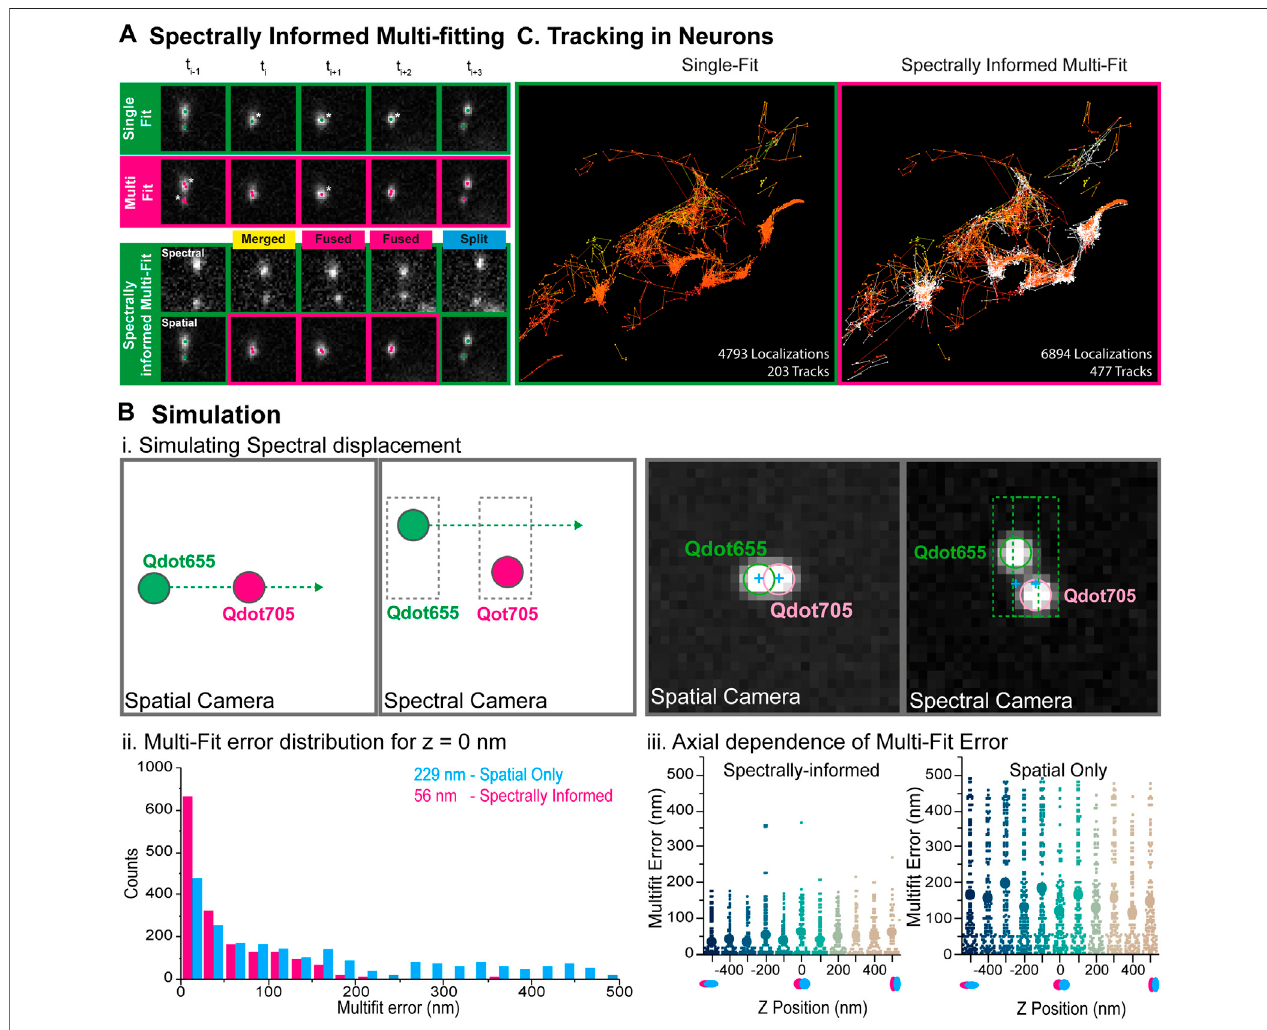
FIGURE4| Spectrally-informedmulti- fi ttingprincipleandbenchmarkingthroughsimulations. (A) Principleofthespectrally-informedmulti-Gaussian fi ttingmethod. When two fl uorescent single particles diffuse together within an area smaller than the diffraction limit of light, it becomes impossible to localize them individually and extract their exact trajectories. A systematic single Gaussian- fi tting approach leads to under-counting localization (top) whereas a systematic multi-Gaussian fi tting approach sometime leads to over-counting localizations (middle) (Stars indicate over- or under-counting errors in the localization process). If those particles have different spectral signatures, they will be separated in the spectral channel, allowing to precisely determine the number of particles, and to use the multi-Gaussian fi tting algorithm when needed to retrieve their coordinates (bottom). The Spectrally-informed multi-Gaussian fi tting (magenta) occurs when two emitters overlap on the spatial channel (single localization) and two distinct localizations are detected on the spectral channel. (B) Multi-Gaussian fi tting simulation for benchmarking. (i.) Simulation principle: Two spectrally-distinct emitters (QDot 655 and QDot 705) were simulated for the spectral and spatial cameras for 320 frames. QD655 displaces horizontally across the fi eld of view at 10nm/frame such that the emitters begin separated, then overlapped on the spatial camera but not on the spectral camera, and fi nally separated again. Right: True camera noise and PSF sizes were used in the simulations. The two emitters overlap on the spatial camera, but not on the spectral camera. (ii.) Thelocalizationerrorforeachofthemulti-Gaussian fi ttingmethods(withoutandwithspectralinformation)iscalculatedandcomparedtothesimulatedlocalizationfor simulatedseparation distances up to+/- 500 nm. Systematicallyperformingthe multi-Gaussian fi ttingresults in amean square error of229 nm (magenta),while utilizing the spectrally-informed multi-Gaussian fi tting algorithm results in a 4x reduction of localization error to 56 nm (cyan). (iii.) The same horizontal-displacement simulation wasthen performed for various simulated astigmaticz-positions between − 500 and 500 nm. Mean error for each ofz-position is plotted for each fi ttingmethod (without (right) and with (left) spectral information), illustrating that the spectrally-informed multi- fi tting signi fi cantly improves the localization precision across the range of assignableaxialpositions. (C) SimultaneousthreecolorsQdotstrackingwithinlivingneurons.Reconstructedtrajectoriescomputedfromsystematicsingle-emitter fi tting (left) or spectrally informed multi-Gaussian fi tting (right). Spectrally-informed Gaussian fi tting leads to ≈ 1.5 times more localizations and ≈ 2 times more